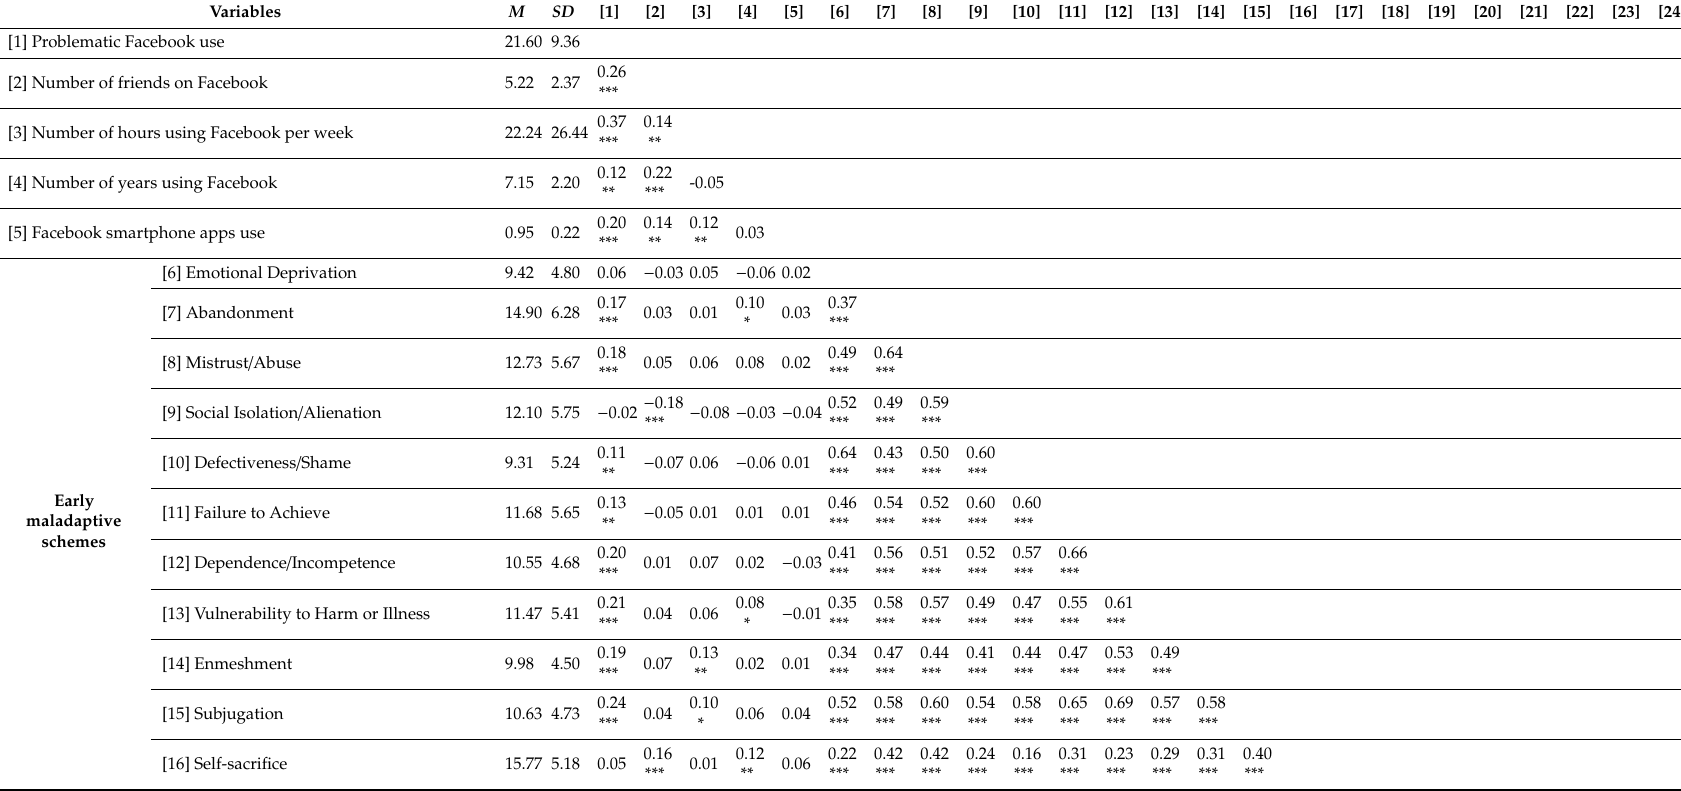
Table 2. Mean values, standard deviations and correlation coe ffi cients between analysed variables ( N =